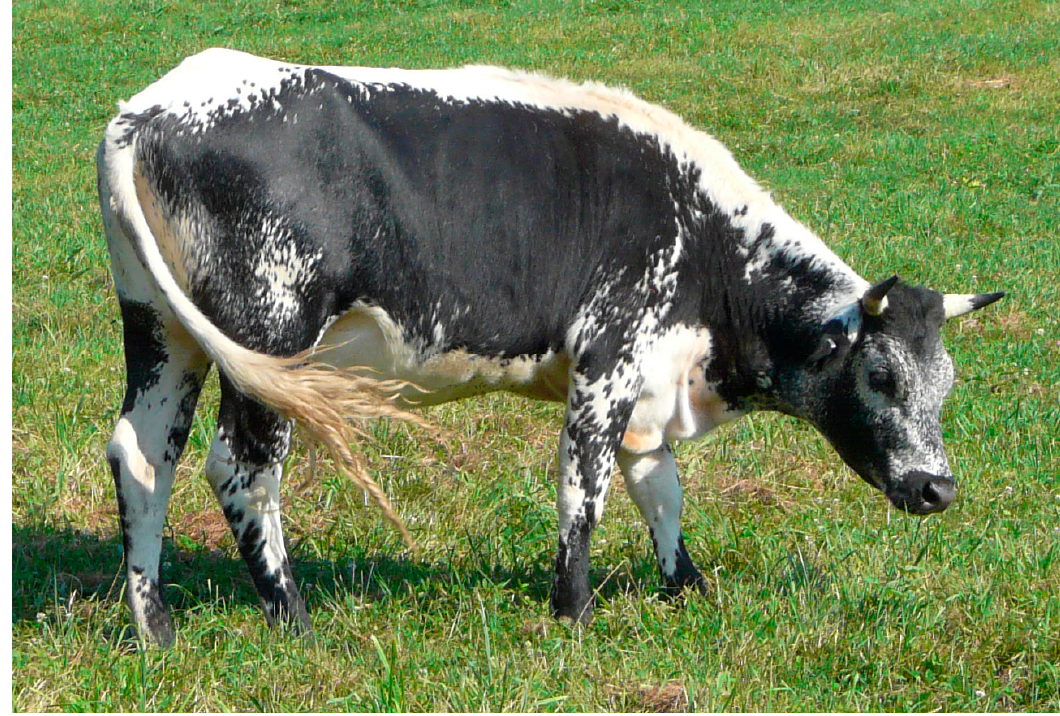
Figure 5. Randall Lineback cattle are a New England landrace. Photo by D.P. Sponenberg.